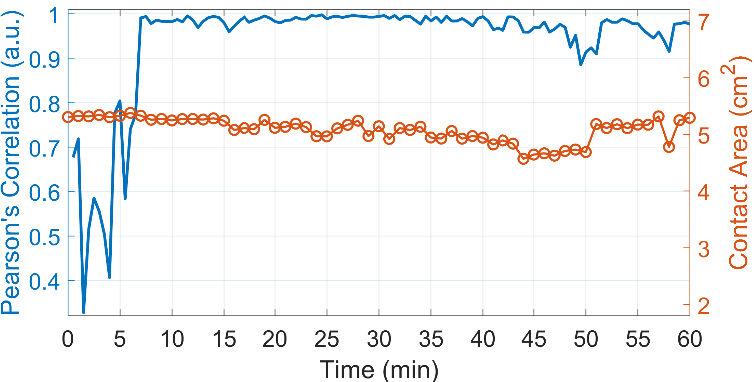
Figure 3. A typical example of the dynamics of experimental parameters for one of the subjects. The blue curve shows the Pearson correlation coefficient between the spatial distributions of perfusion estimated every half minute. The red curve shows the area of contact between the heating element and the skin. The heating element was turned on at the 5th and off at the 25th minute.